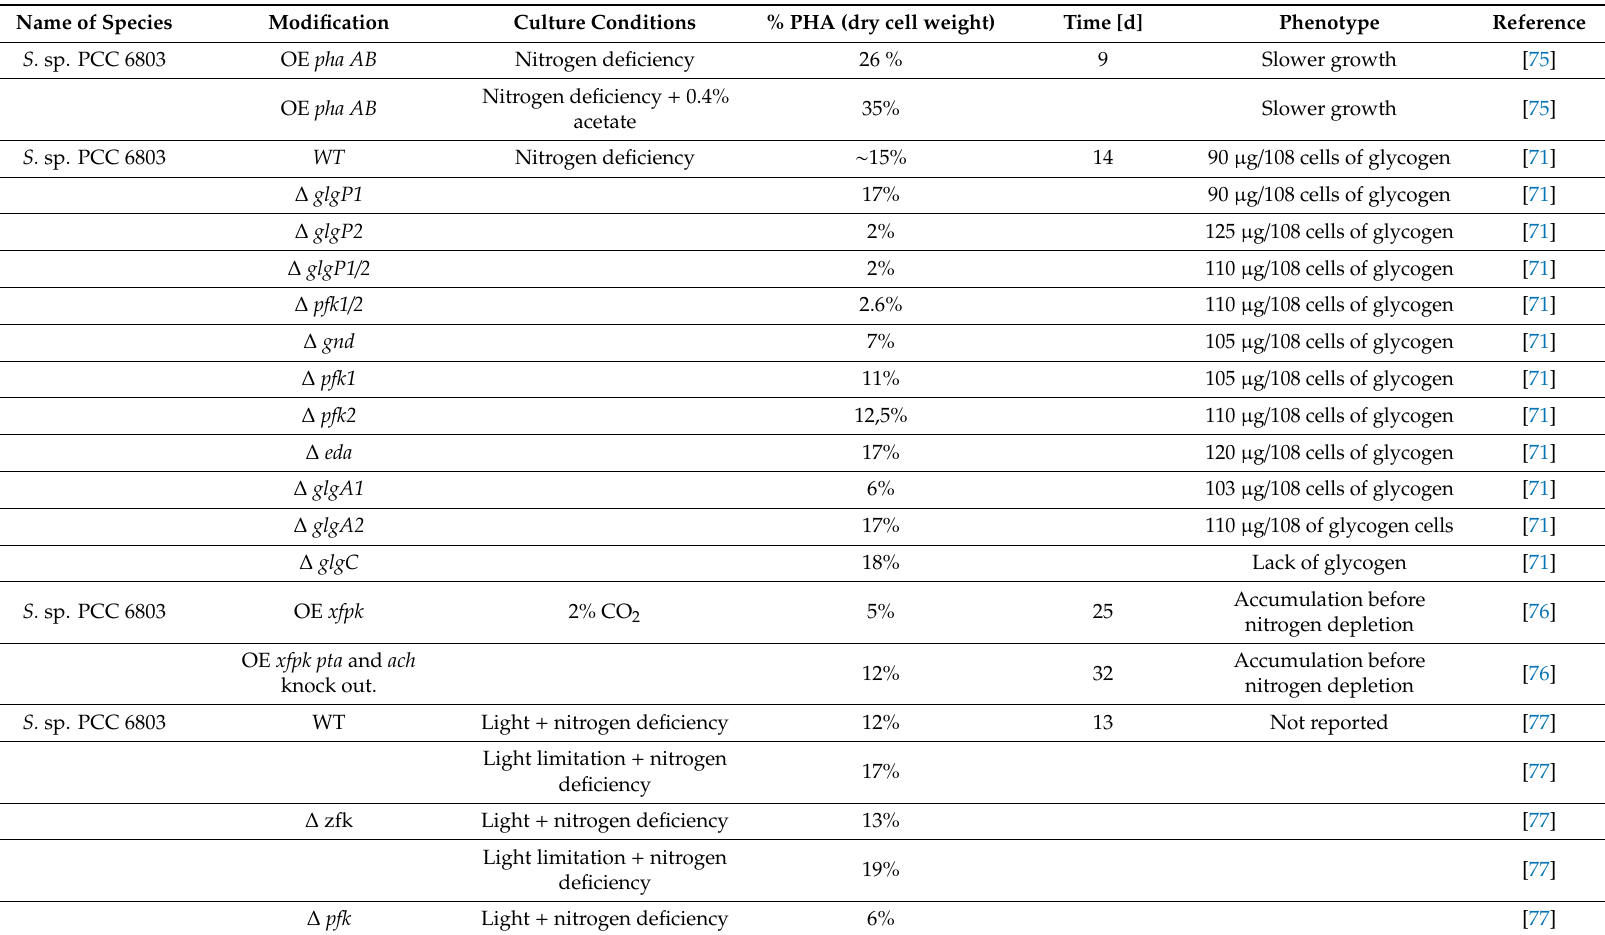
Table 2. Recent studies with mutant strains of cyanobacteria producing polyhydroxybutyrate